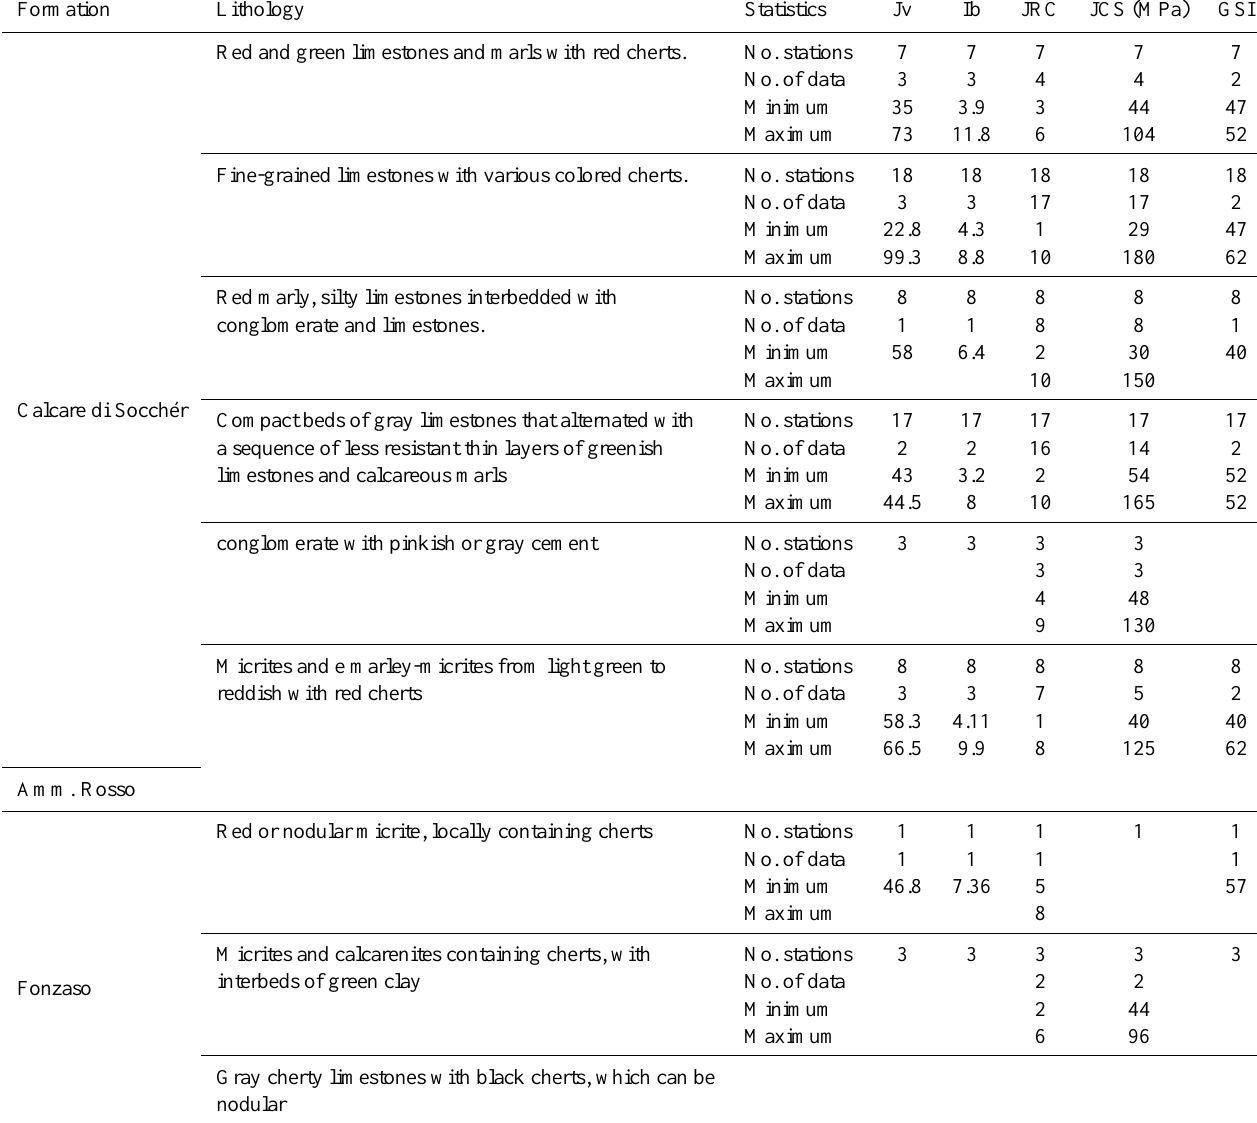
Table 1. Geomechanical properties of the material involved in the slide, from past and current surveys. The slip surface has been placed at the bottom of the Calcare di Socch´er formation (Semenza, 1965). Volumetric Joint Count (Jv), Block Size Index (Ib), Joint Roughness Coefficient (JRC), Joint Compression Strength (JCS), Geological Strength Index (GSI). Formation Lithology Red and green limestones and marls with red cherts.